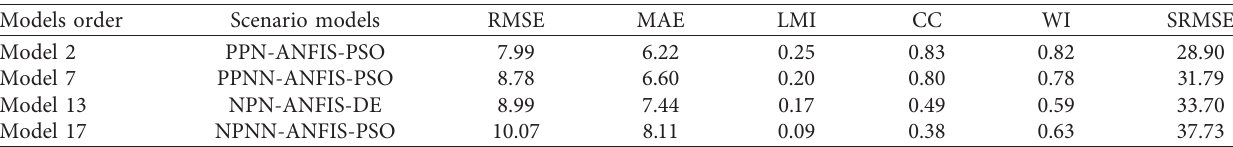
Table 6: Summary of the best statistical performance of the developed hybrid ANFIS for all the examined modeling scenarios over the testing modeling phase.